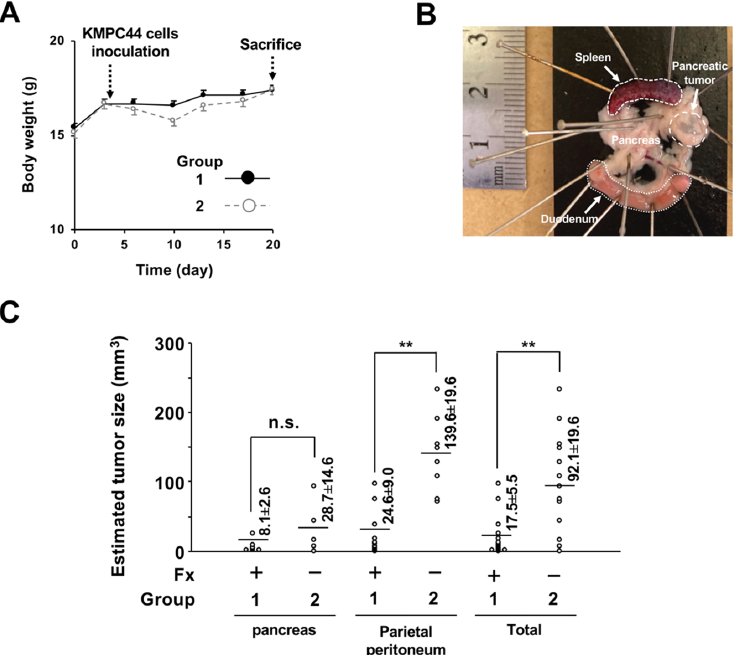
Figure 3. Body weight and estimated tumor size in pancreatic cancer model mice. ( A ) Body weight changes during the period of Fx diet administration. Black and white dots indicate groups 1 and 2, respectively. ( B ) Macroscopic observation of a pancreatic tumor in mice with allogenic and orthotopic transplantations of KMPC44 cells just after sacrifice (white arrow). ( C ) Estimated pancreatic tumor size in pancreatic and parietal peritoneum tissues in mice. The tumor size of tumors with ≥ 1 mm of major axis was estimated based on a formula: a (mm) × b 2 (mm)/2 (a, long range; b, short range). Means ± SE ( n = 6–21). ** p < 0.01. n.s., no significance.